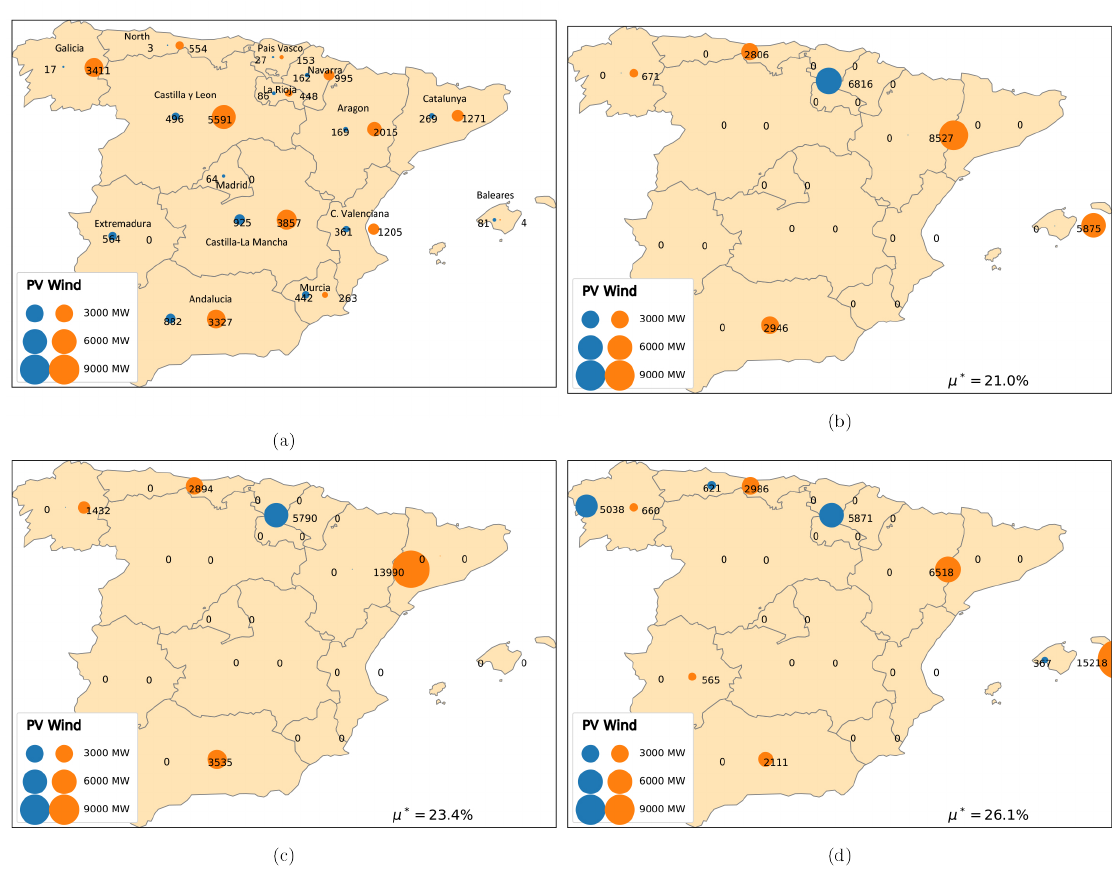
Figure 3. Maps representing renewable IC in Spain for PV (blue) and wind (orange). ( a ) REE-reported 2018 mix. CTL/CAL ( b ) low-risk, ( c ) high-penetration and ( d ) free high-penetration